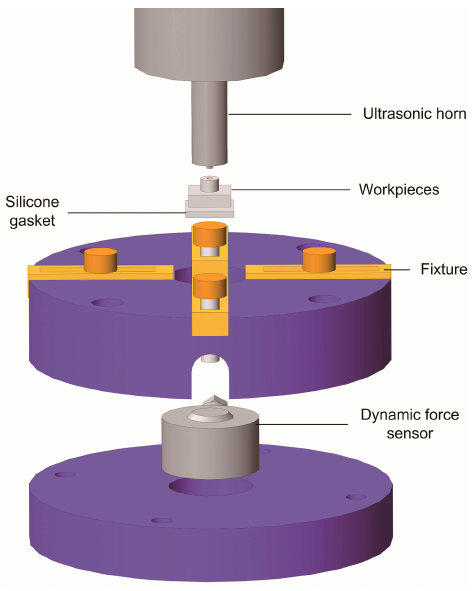
Figure 7. Structure of anvil equipped with dynamic force sensor.